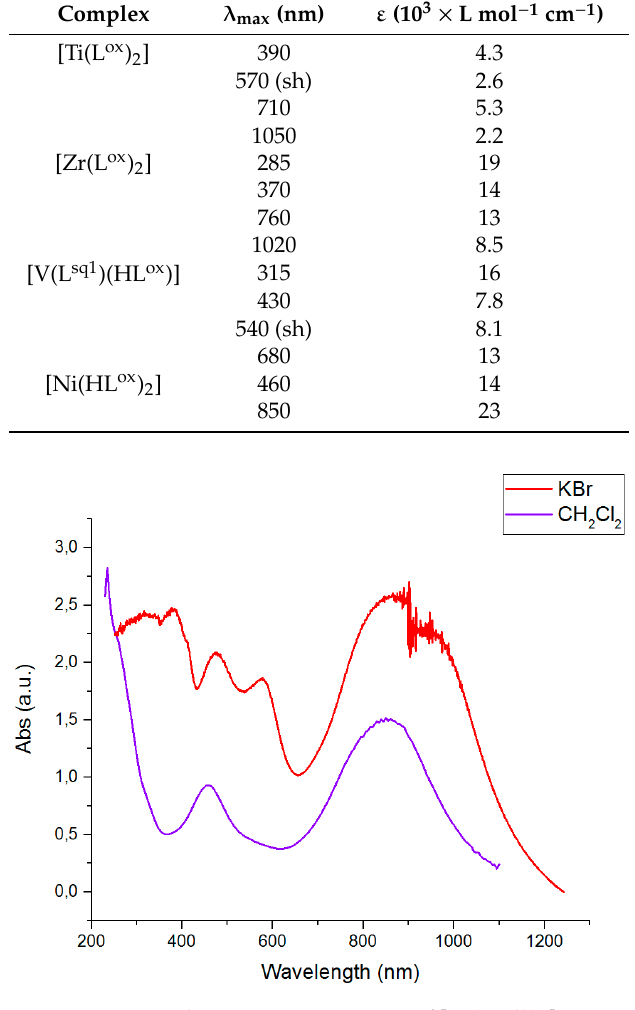
Figure 5. The UV-vis-NIR spectra of [Ni(HL ox ) 2 ].